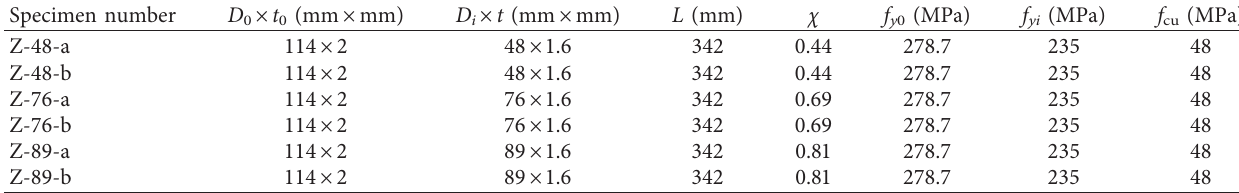
Figure 1: Section diagram of CFSSAST Table 1: Size and strength of axial compression specimens.